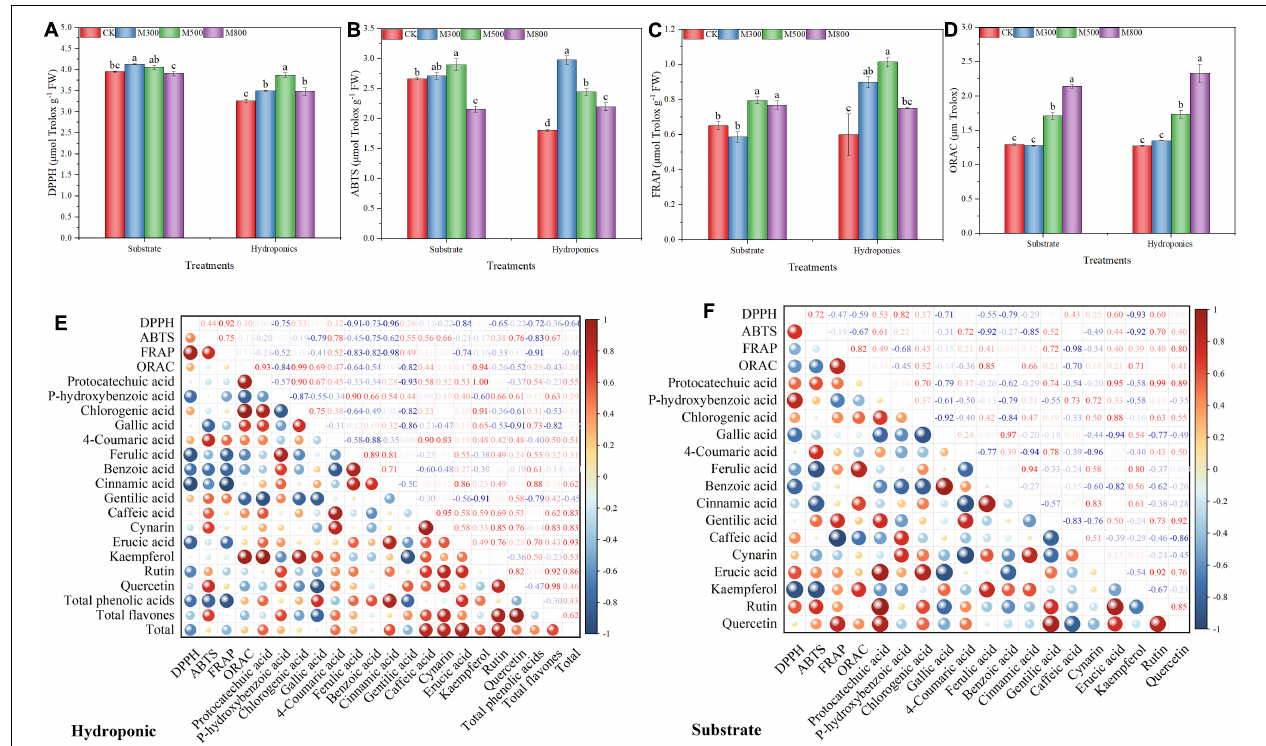
FIGURE 7 | The 2,2-diphenyl-1-picrylhydrazyl (DPPH) radical scavenging capacity (A) , Trolox-equivalent antioxidant capacity (ABTS) (B) , ferric-reducing antioxidant power (FRAP) (C) , and oxygen radical absorbance capacity (ORAC) (D) of Chinese chives grown in substrate or hydroponics as affected by methyl jasmonate (MeJA) treatments. Data represent the mean ± standard error ( n = 3). Different lowercase letters indicate statistical significance, by Duncan’s multiple range tests ( p < 0.05). The heat map shows the Pearson correlation analysis between the observed parameters of antioxidant capacity and the observed parameters of phenolic compounds in MeJA treated hydroponic (E) or substrate (F) Chinese chive. The values in the heat map are Pearson’s correlation coefficient. The size and color depth of the colored balls correspond to the strength of the correlation, ranging from weak (small balls, blue) to strong (large balls,